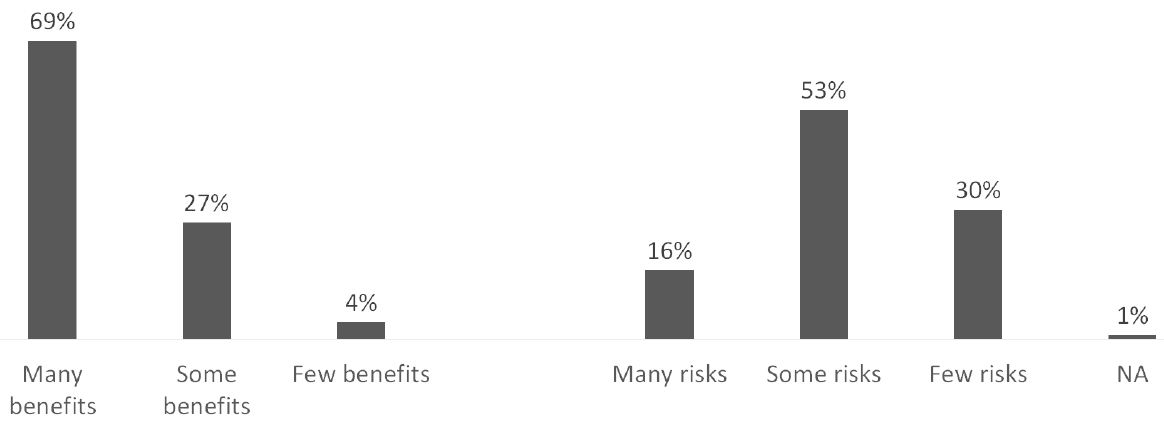
Figure 3. Benefits and risks of S&T. Survey questions related to Figure 3: